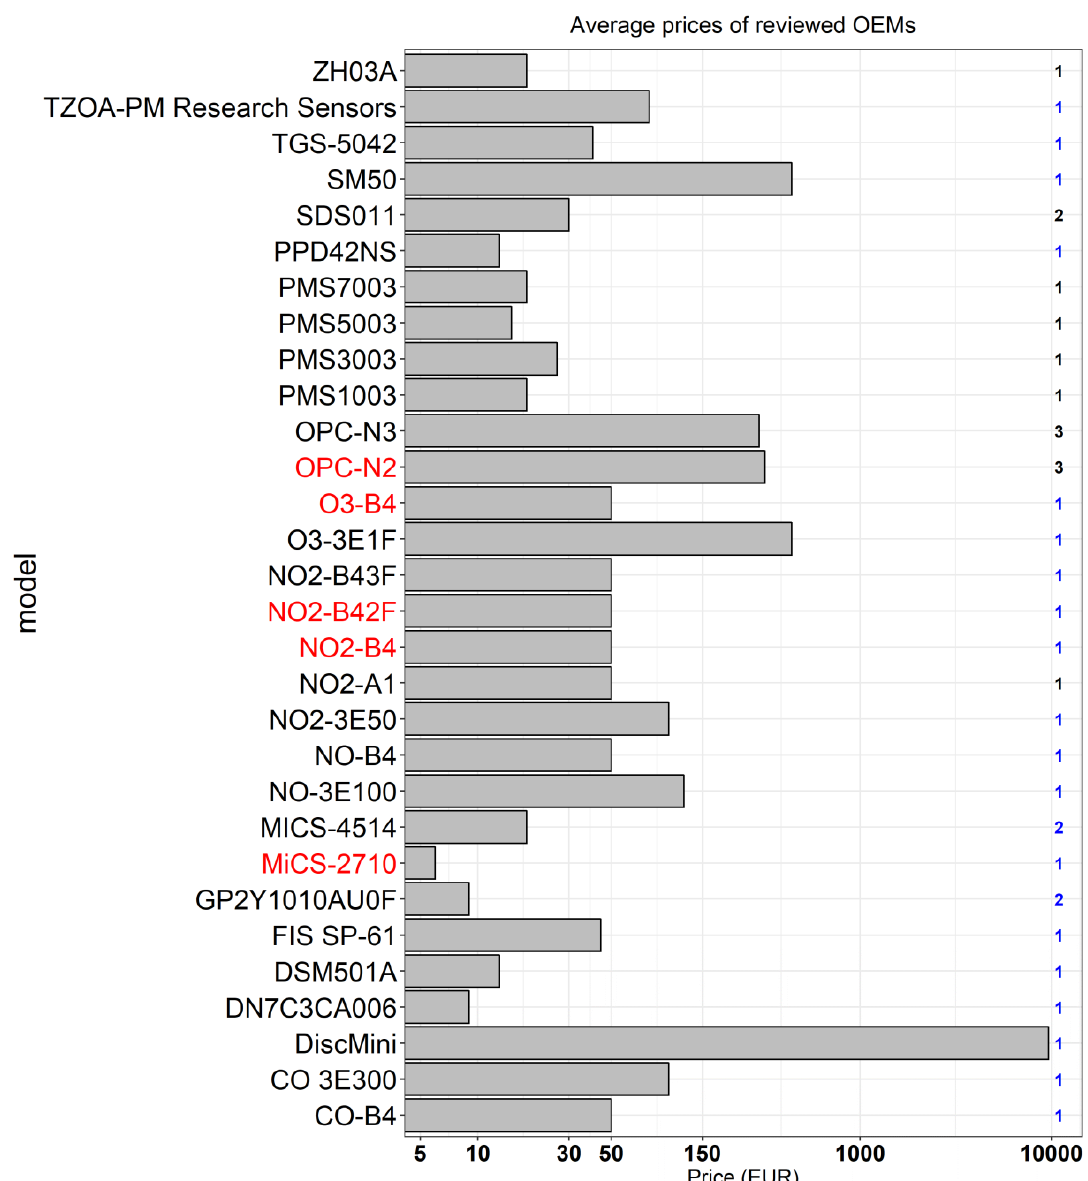
Figure A13. Prices of OEMs grouped by model. Numbers at right indicates the number of pollutants measured by each OEMs, with open source in blue and black box in black. The x-axis uses a logarithmic scale. Names of “living” and “non-living” OEMs are indicated by black and red for the labels on the y-axis, respectively.